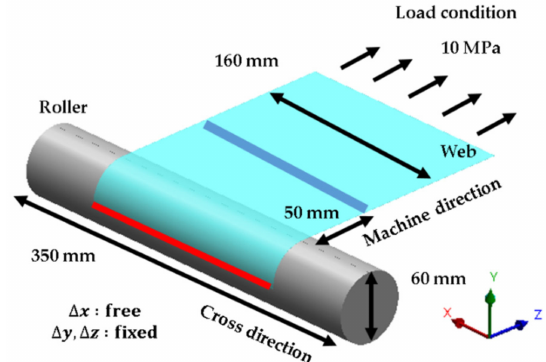
Figure 1. Schematic of finite element (FE) model: Red lines are fixed in the machine direction (MD); the blue line represents the target printing